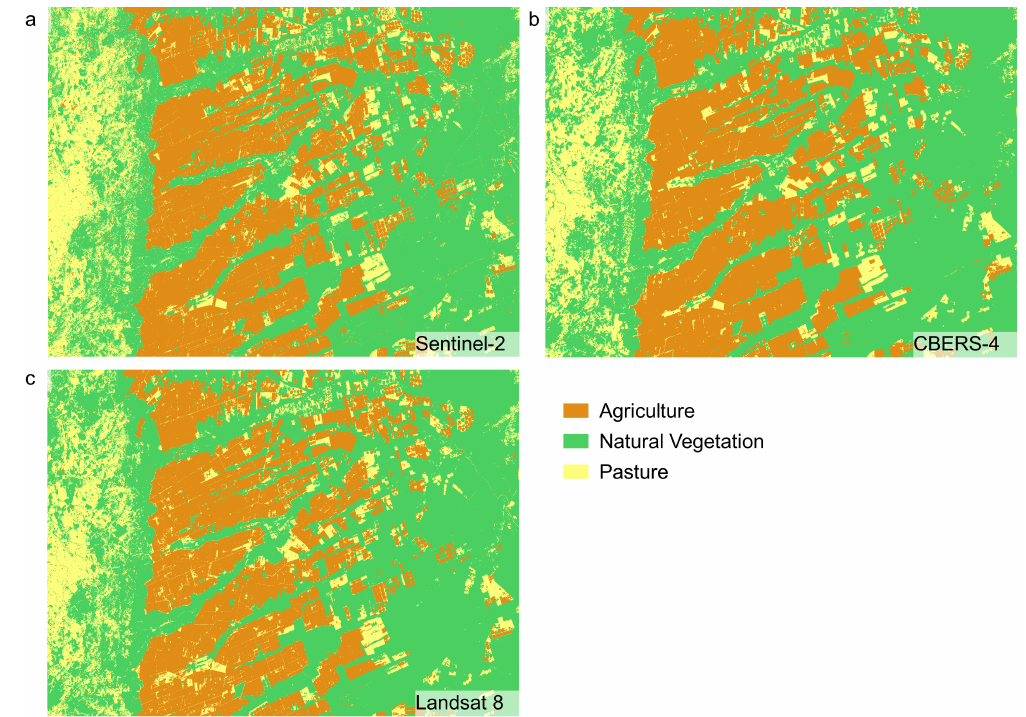
Figure 12. Deep learning classification using ( a ) Sentinel-2, ( b ) CBERS-4, and ( c ) Landsat 8 stack compositing monthly data cubes, from September 2018 to August 2019.